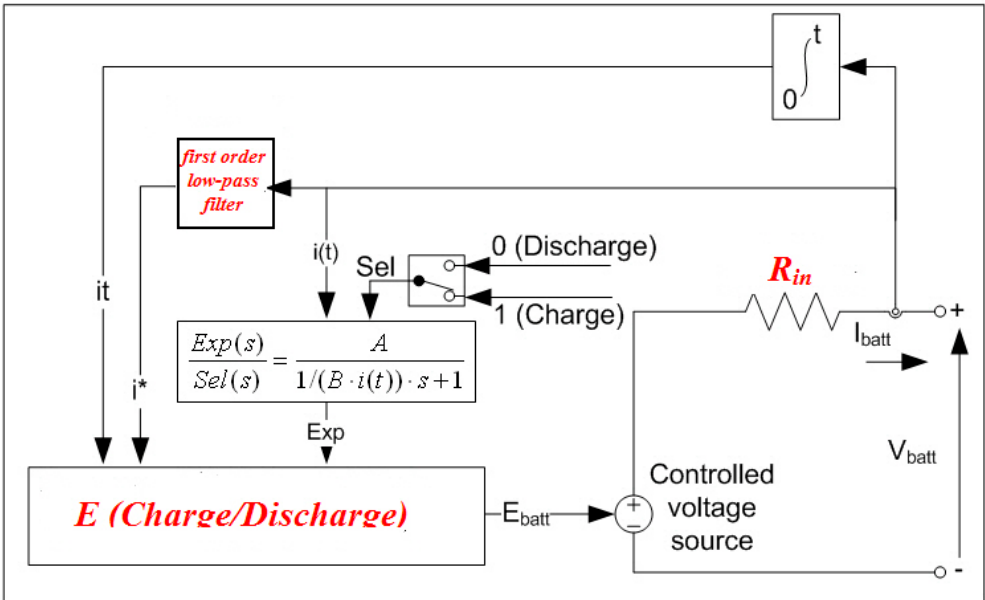
Figure 8. Battery equivalent circuit.